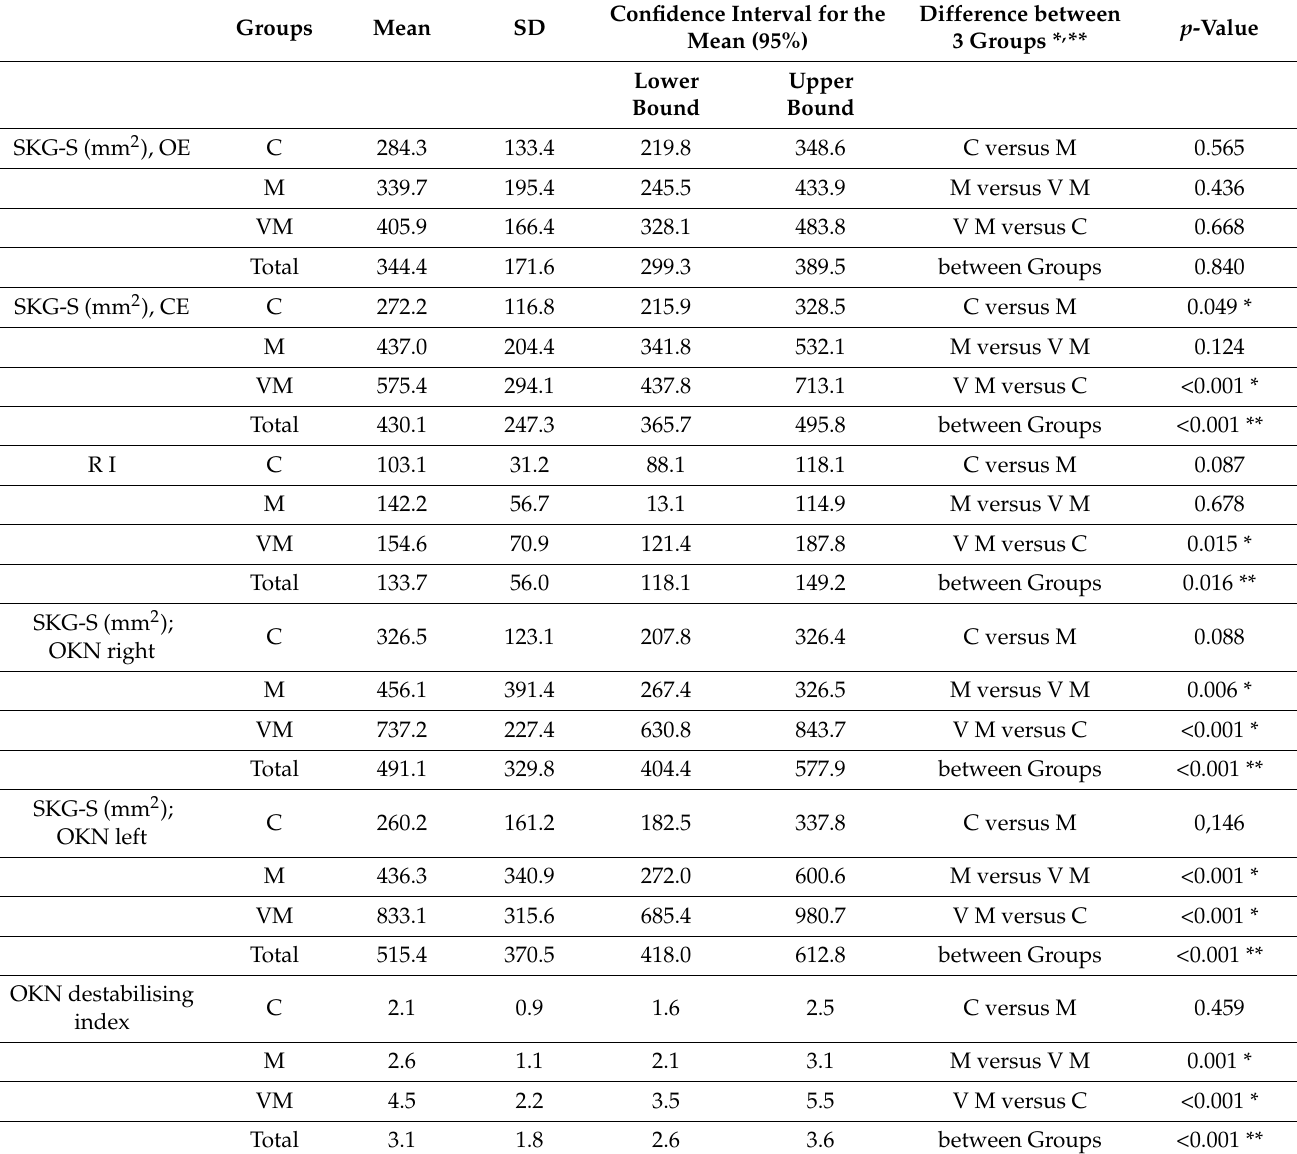
Table 2. Stabilometric parameters; mean value, standard deviation, confidence interval (95%) with lower and upper bounds, are reported for each